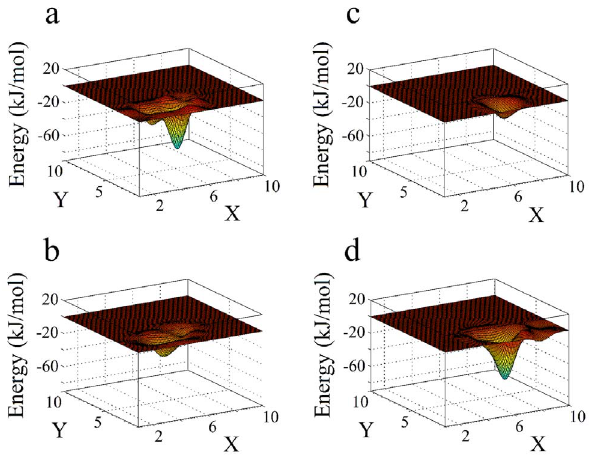
Figure 7. Full average trajectories obtained by Molecular Dynamic Simulations. (a) shows the average trajectories of caffeine (blue squares) and tetracaine (red dots) at independent simulations (ten molecules for each case) and (b) shows the average trajectories of both molecules in the same simulation (five and five). The dashed lines delimit the polar head lipid region of the upper membrane surface. The error bars are calculated by considering the trajectories of all the molecules used in the simulations. See details in the text.